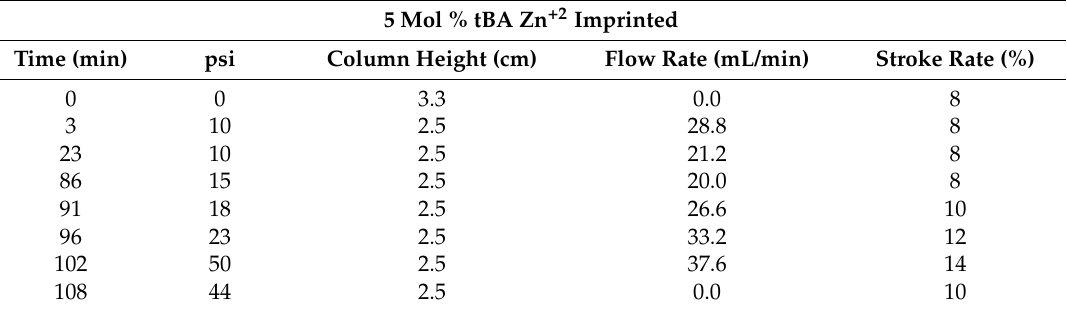
Table 4. Maximum flow rate and pressure in 5 mol % tBA imprinted.